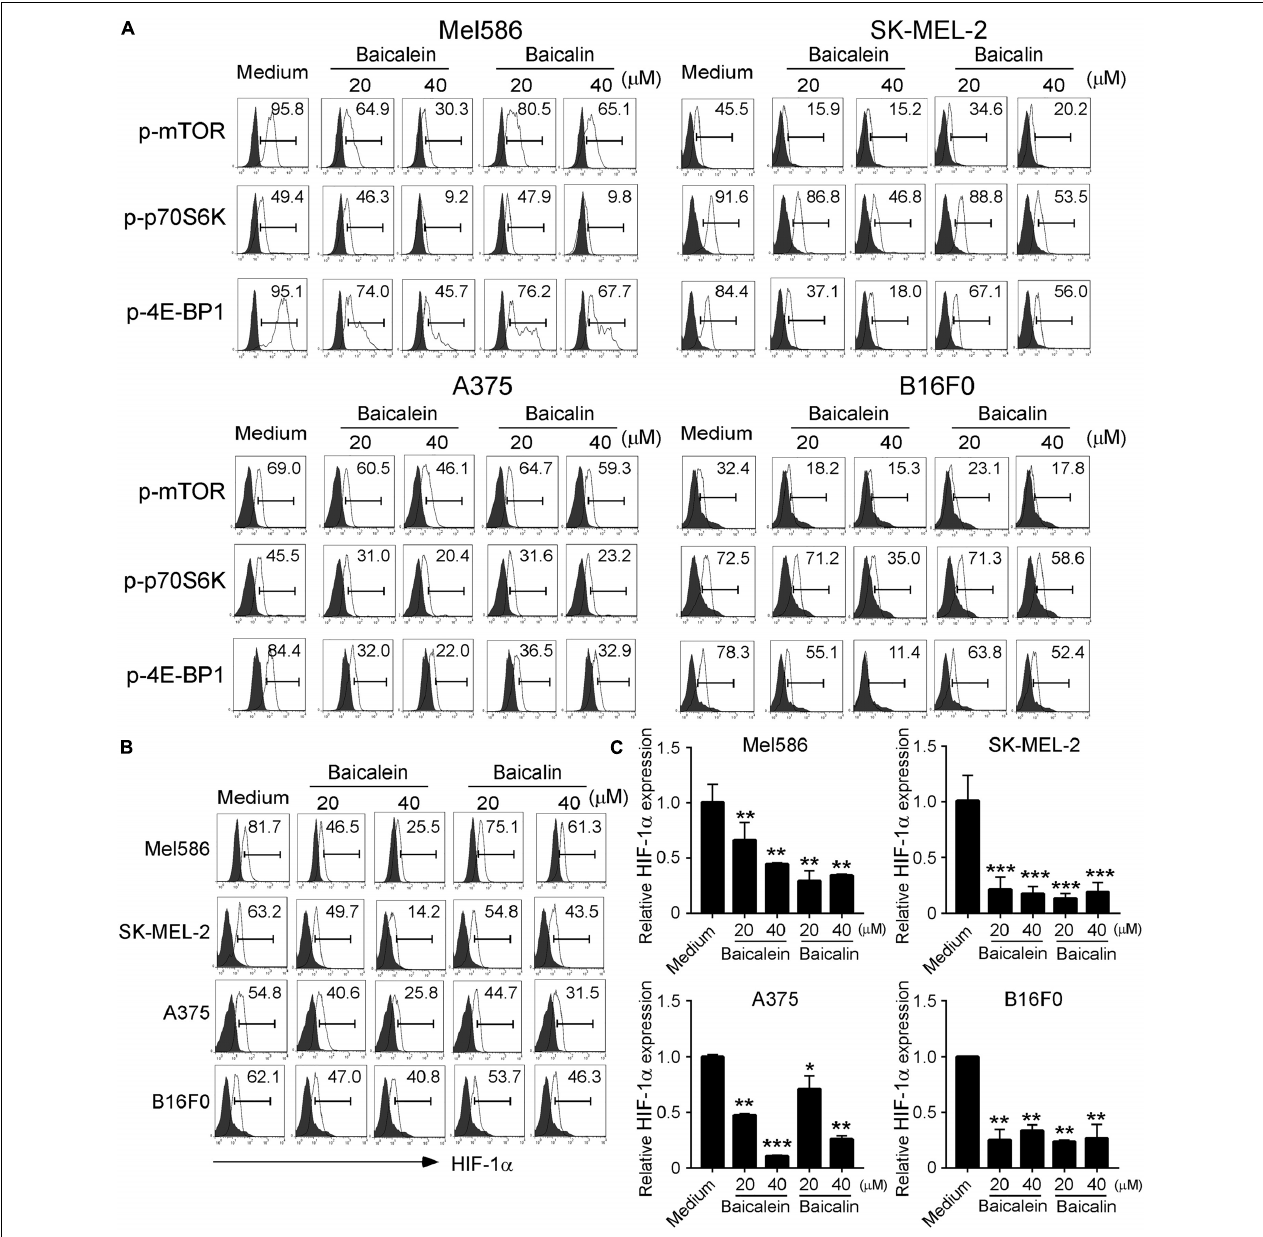
FIGURE 6 | Baicalein and baicalin treatments suppress mTORC1-HIF α signaling in melanoma cells. (A) Suppression of phosphorylation and subsequent activation of mTOR signaling in melanoma cells treated with baicalein and baicalin. Melanoma cells were treated with or without indicated concentrations of baicalein and baicalin for 72 h and then phosphorylated mTOR, p70S6K, and 4E-BP1 in tumor cells were determined by the flow cytometry analyses. (B,C) Baicalein and baicalin treatments down-regulated HIF1 α protein and mRNA expression in melanoma cells. Cell preparation and treatment were identical to panel (A) . The protein expression of HIF-1 α in treated tumor cells was determined by the flow cytometry (B) . Total RNA was isolated from the tumor cells and analyzed by Real-time PCR (C) . The gene expression levels of HIF1 α were normalized to β -actin expression levels and adjusted to the levels in untreated melanoma cells. Data shown are representatives of mean ± SD from three independent experiments. * p < 0.05, ** p < 0.01, and *** p < 0.001, compared with the medium only